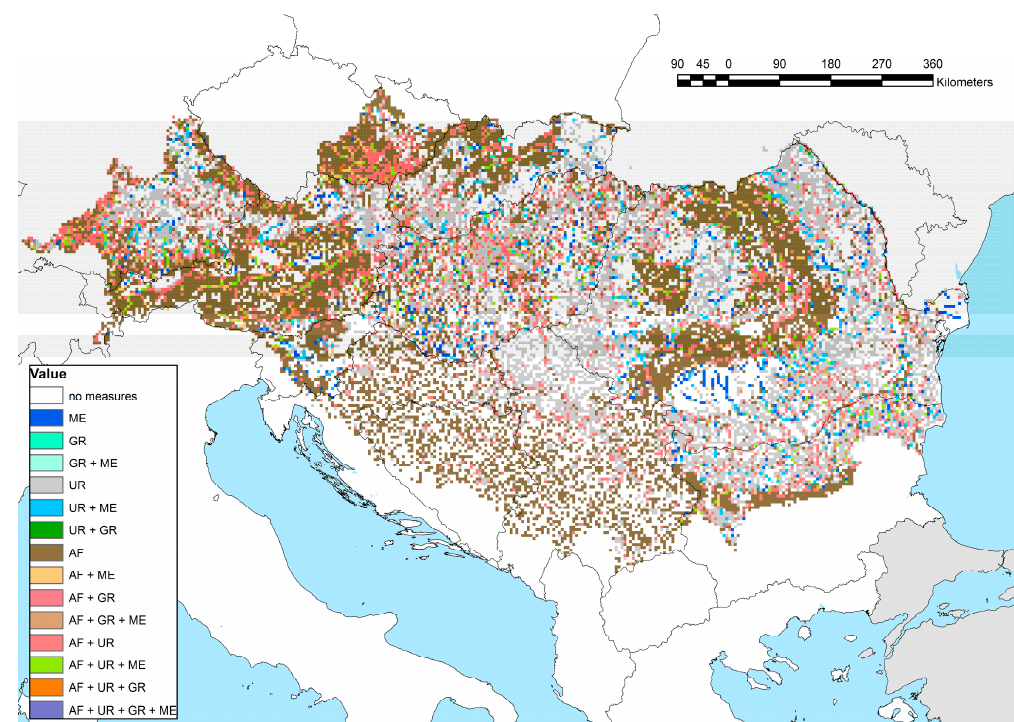
Figure 10. Improvement measure map for the S10 Pareto efficient strategies (from Table 5) for the Danube catchment considering the flooding related family of measures. The S10 strategy applies one or various types of measures in almost all of the region.